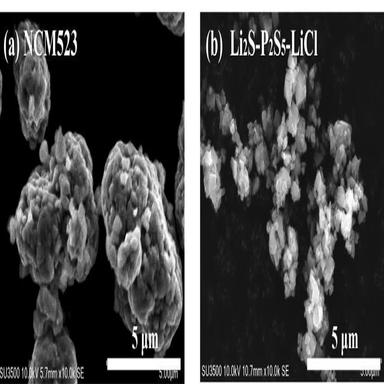
SEM image of (a) NCM523, (b) Li2S-P2S5-LiCl.